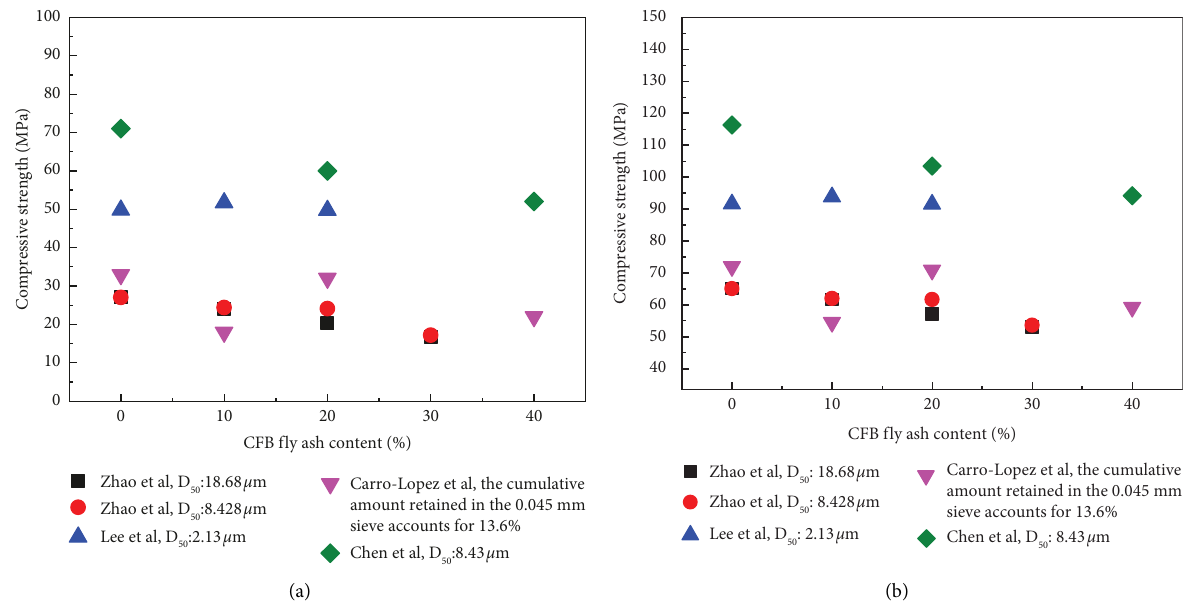
Figure 2: Infuence of CFB fy ash content and fneness on compressive strength of Portland cement mortar. ((a) Compressive strength after 3 days and (b) Compressive strength after 28 days) [7,